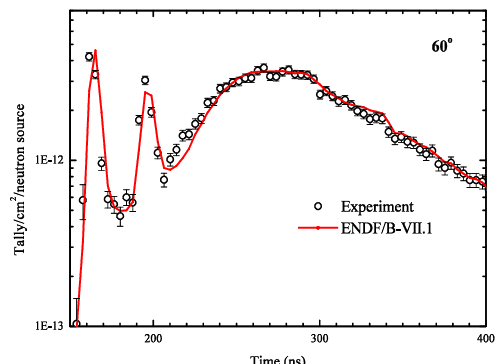
Fig.4 Leakage neutron spectrum from polyethylene sample at 60° (30 cm×30 cm×6 cm).